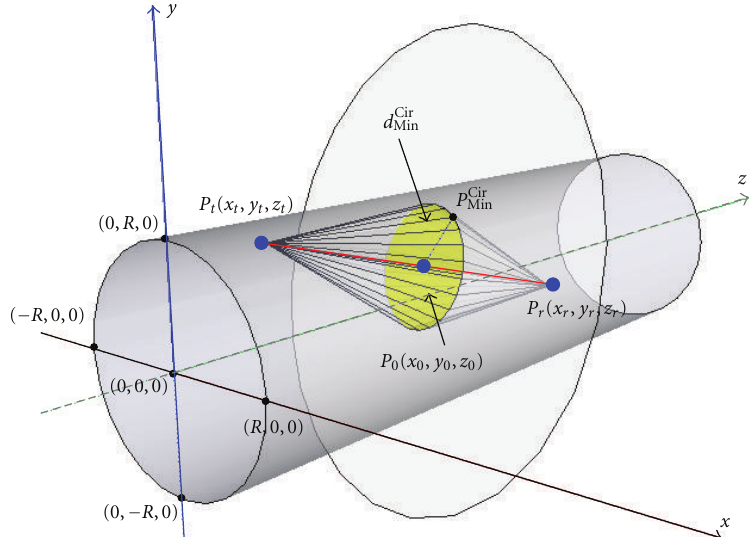
Figure 4: Detailed schematic diagram of the propagation inside circular tunnels with the first Fresnel zone